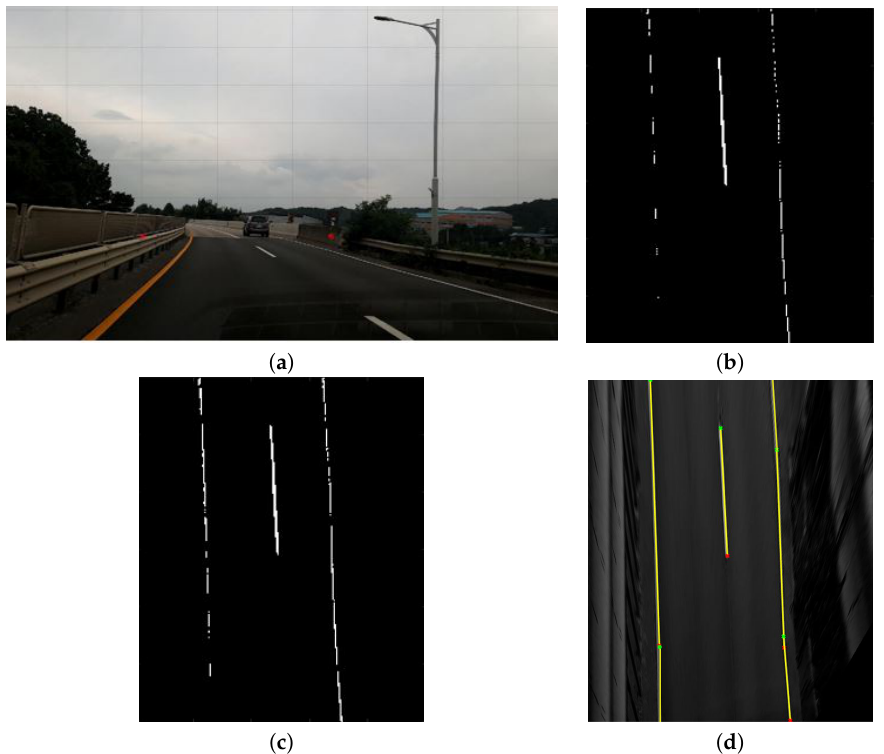
Figure 5. Examples of detection of vehicle lines: ( a ) original image; ( b ) image after edge detection; ( c ) image after edge operation; ( d ) image after vehicle line